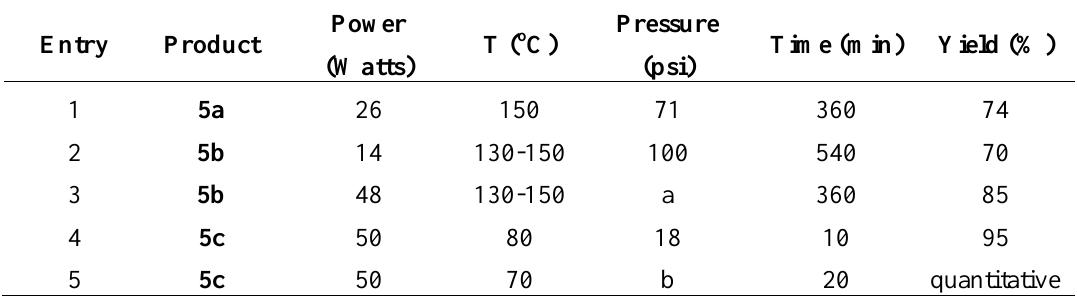
Table 2. 1,4-Addition of ( S )- α -methylbenzylamine to α , β -unsaturated